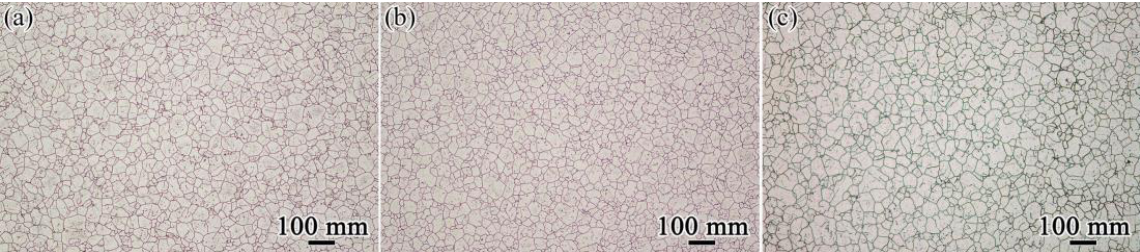
Figure 2. The optical microstructure of 15Cr–15Ni–Ti-xP alloy after being solution treated at 1120 °C for 2 h: ( a ) 15Cr–15Ni–Ti–70P alloy, ( b ) 15Cr–15Ni–Ti–150P alloy and ( c ) 15Cr–15Ni–Ti–250P alloy.